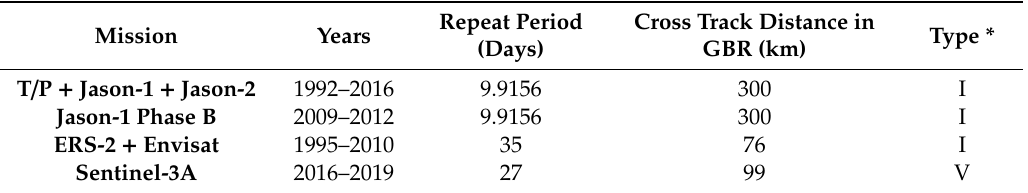
Table 1. The satellite data used in this study.